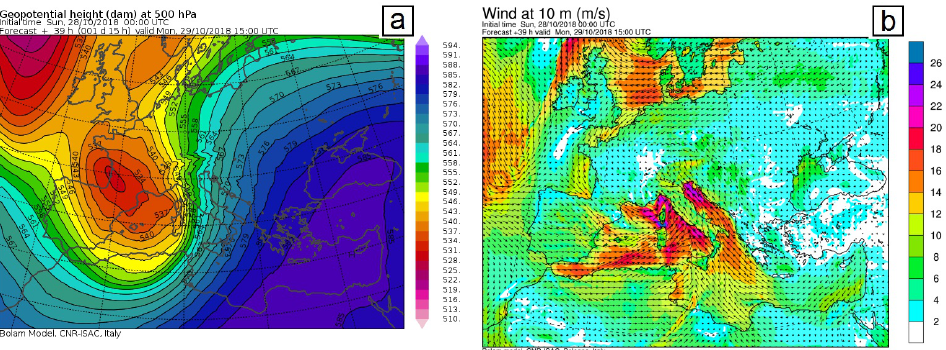
Figure 11. 29 October 2018 15:00 UTC: ( a ) Geopotential height (dam) at 500 hPa; ( b ) Wind (m/s) at 10 m (Bolam